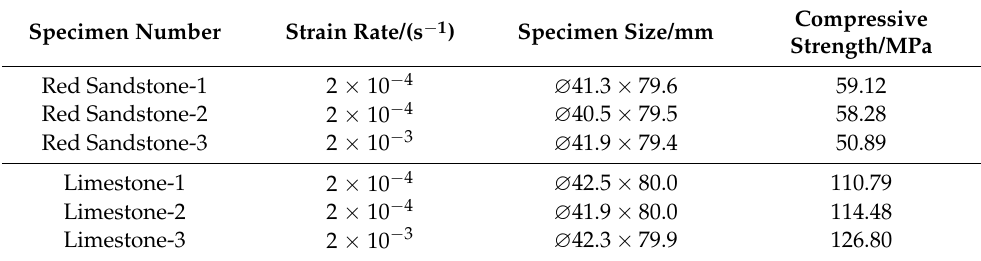
Table 1. Groups of quasistatic compression